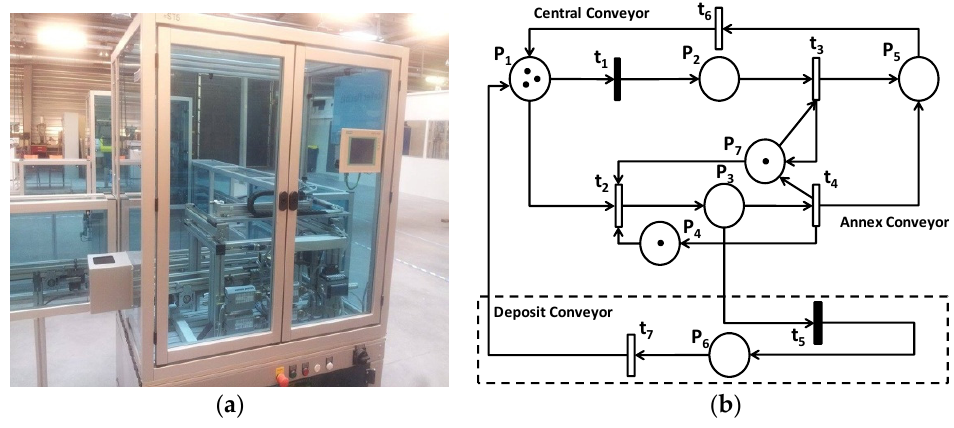
Figure 8. Quality control station: ( a ) experimental environment; and ( b ) PN model.